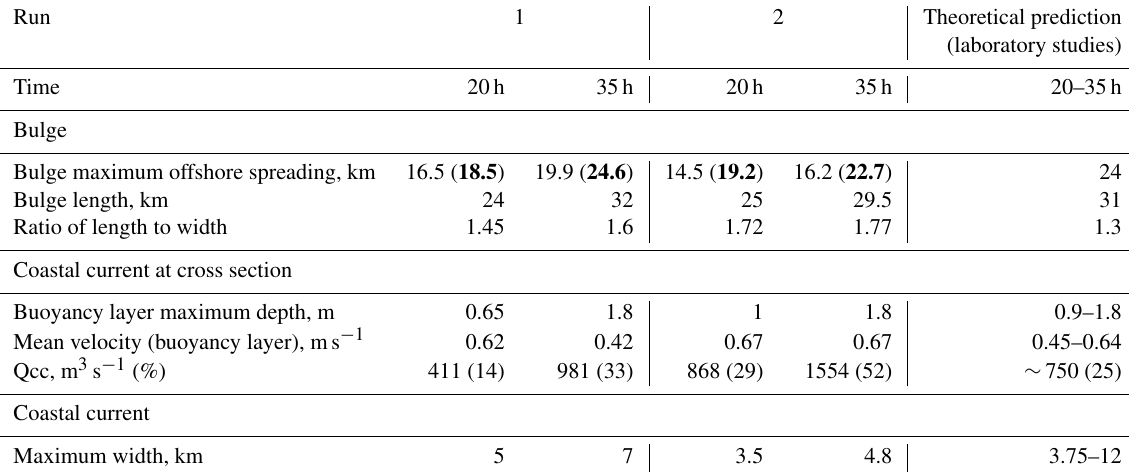
Table 2. Summary of the results after 20 and 35h of runs 1 and 2. The mean value of the coastal current discharge at different time moments should be compared with the analytical solution. Numbers in bold font demonstrate the bulge offshore spread (width) based on simulated length divided by 1.3; 1.3 is the ratio between the length and width obtained in a laboratory